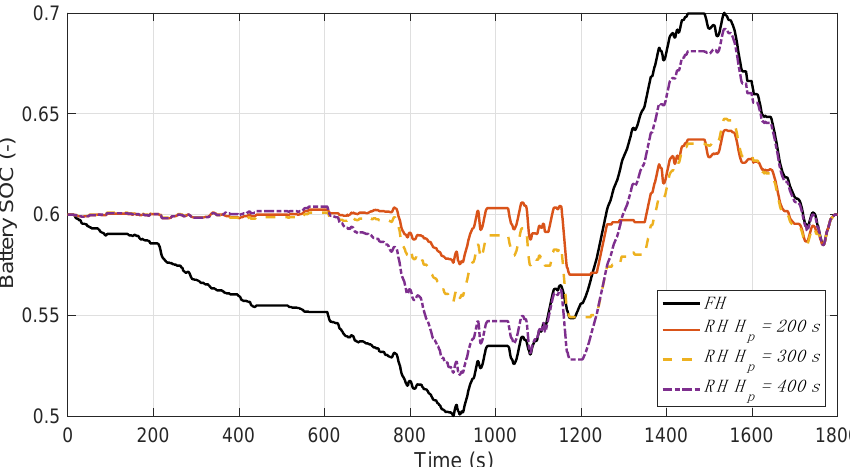
Figure 6. Comparison of SOC trends achieved for the RH approach with different H p windows (constant H s of 150 s).